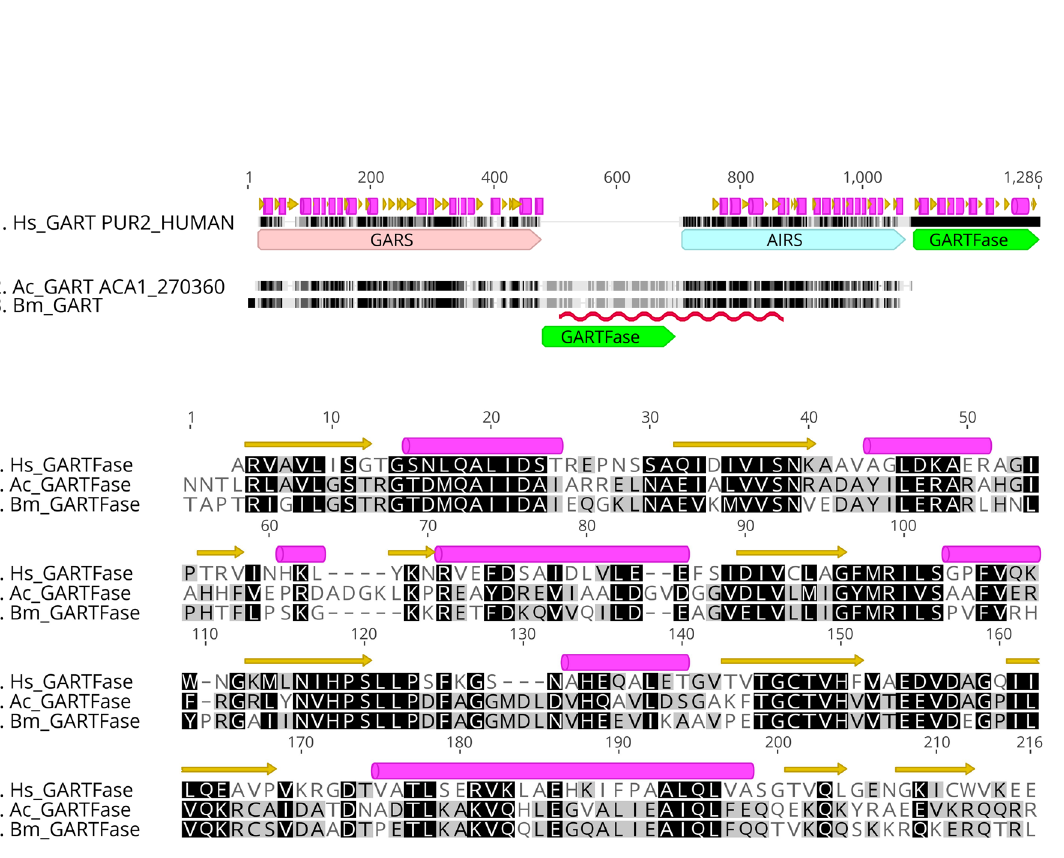
Figure 5. Top: Domain arrangement in human, A. castellanii and B. mandrillaris GART. Domains are annotated as large arrows on the alignment and higher level of residue conservation is represented as darker shades of gray. The region validated by direct sequencing in Balamuthia is underlined with a red squiggle. Secondary structure elements from human GART crystal structures are taken from UniProt. Bottom: Alignment of the GARTFase domains extracted from the GART sequences